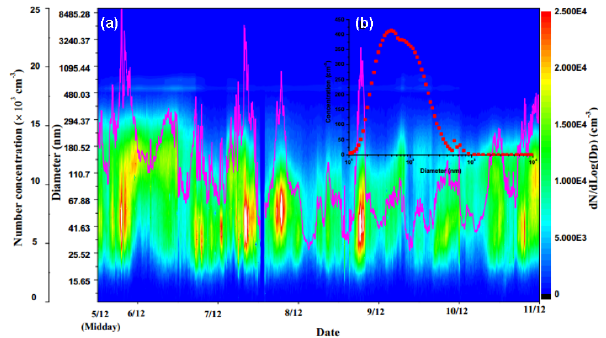
Figure 5. (a) Time series of 4-min mean aerosol number size spec- tra and aerosol number concentration (pink line) and (b) averaged aerosol number size distribution from 5 to 10 December 2013.